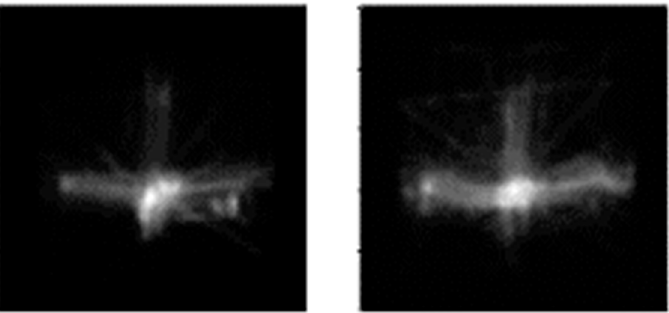
Figure 8. Examples of VAE-generated images.